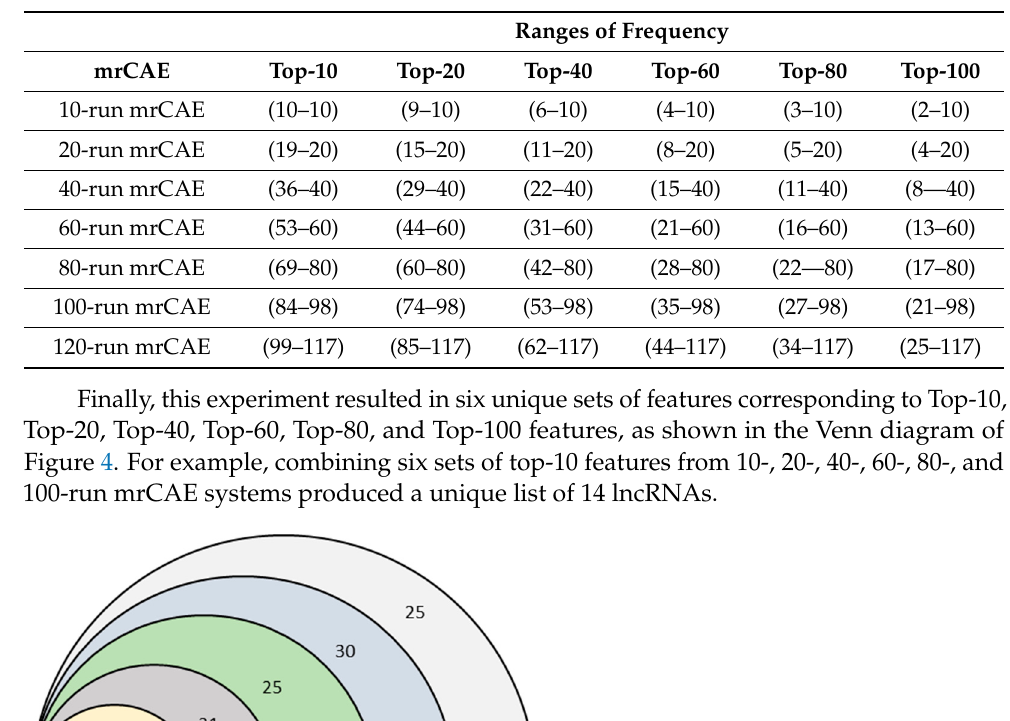
Table 2. Ranges of frequency for the top features in six categories.